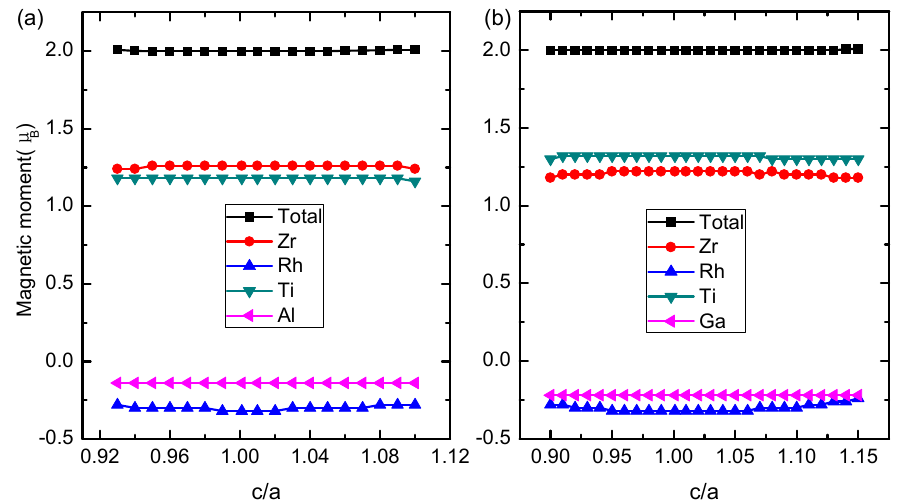
Figure 10. Total spin magnetic moment and atomic spin magnetic moment as a function of c/a ratio (TD) for ZrRhTiAl ( a ) and ZrRhTiGa ( b ).